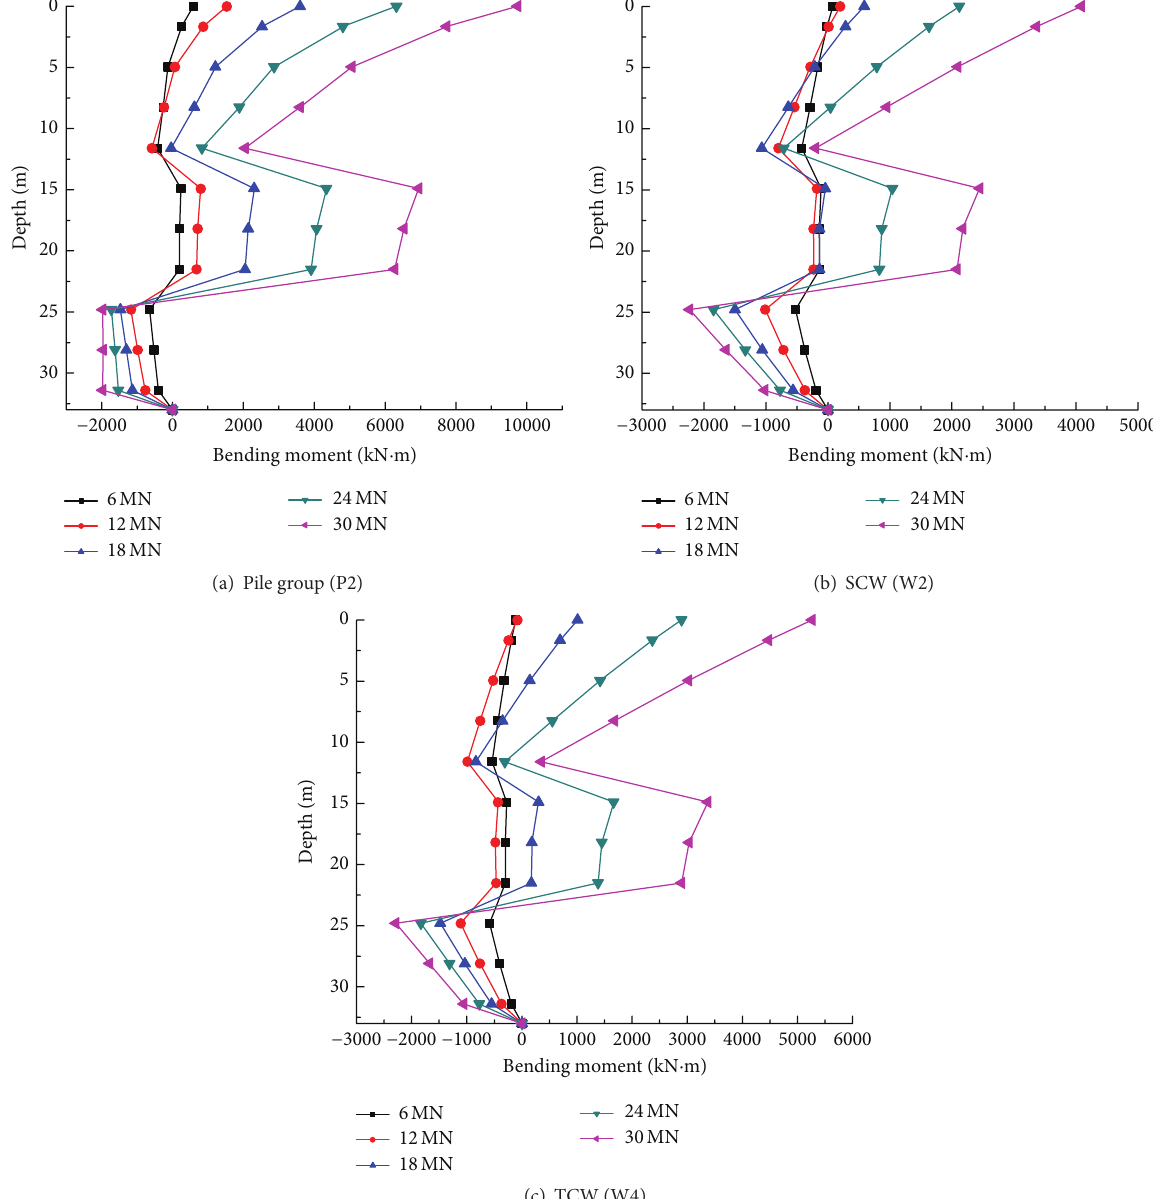
Figure 9: Bending moment of three models under different